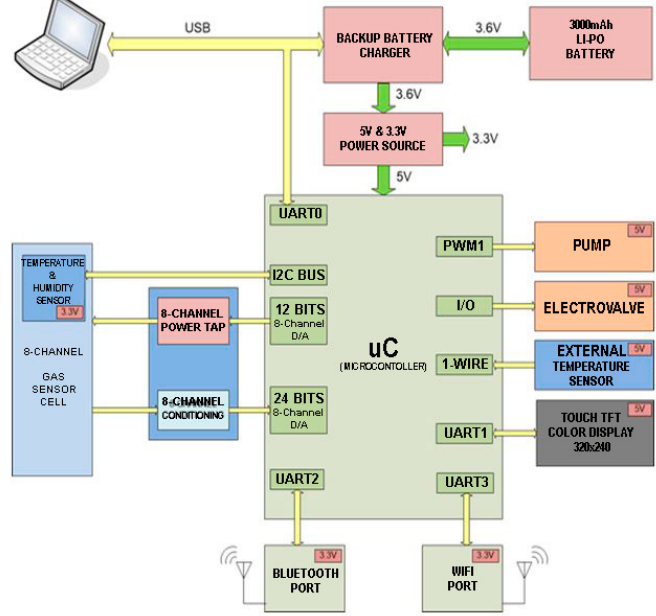
Figure 4. Block diagram of the electronic nose.